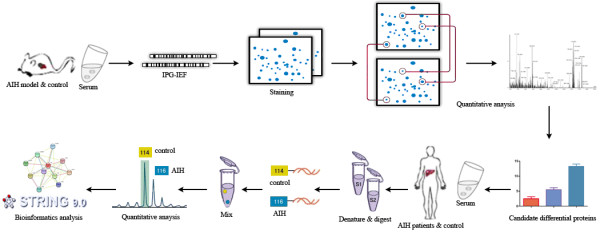
The serum proteome analysis of a mouse model with autoimmune hepatitis by 2-DE and a targeted iTRAQ validation on clinical serum. The pooled serum samples were depleted of albumin and IgG using ProteoExtract Albumin Removal Kit, and protein fractions were used for the subsequent differential expression analysis. Serum protein expression profile of AIH mice was compared with normal mouse serum by 2-DE, differential proteins were identified by MS/MS. On the other hand, the AIH patient’s serum was pretreated and labeled with iTRAQ reagents to perform LC-MS/MS, and the target proteins were selected to validate their expression levels in AIH patient’s sera by iTRAQ quantification.